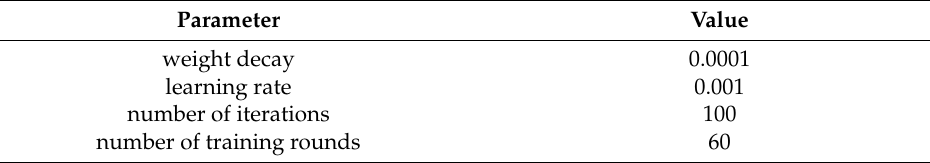
Table 2. Training